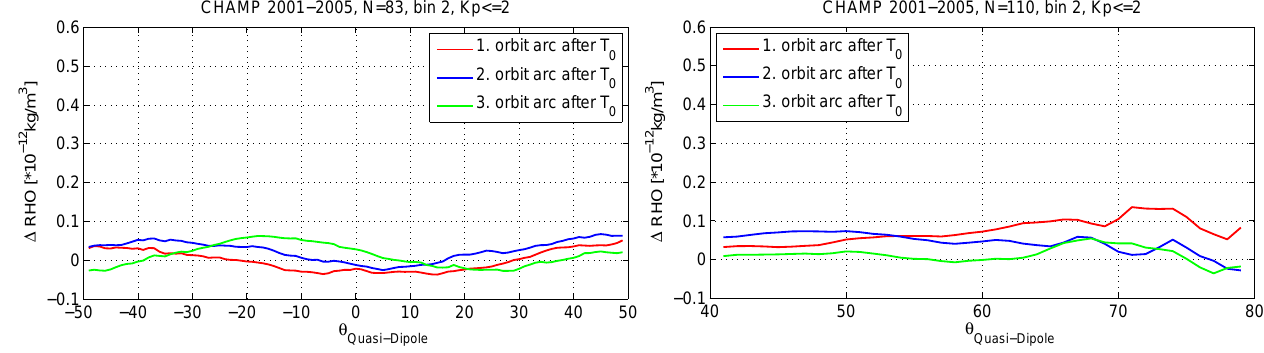
Fig. 6. same as Fig. 5, but for low magnetic activity (Kp ≤ 2). Calculated mean MLT: 24h.